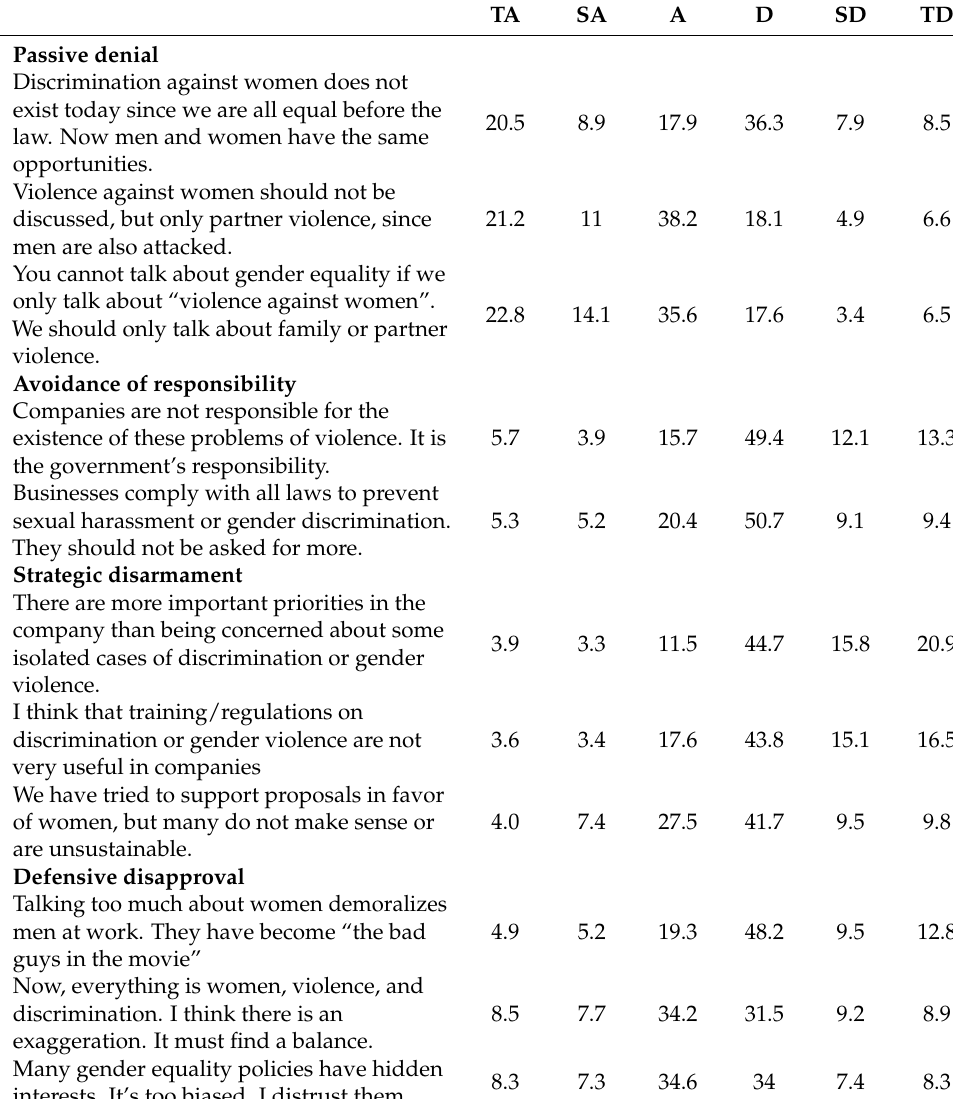
Table 4. Managers’ implicit resistance to gender violence prevention in companies